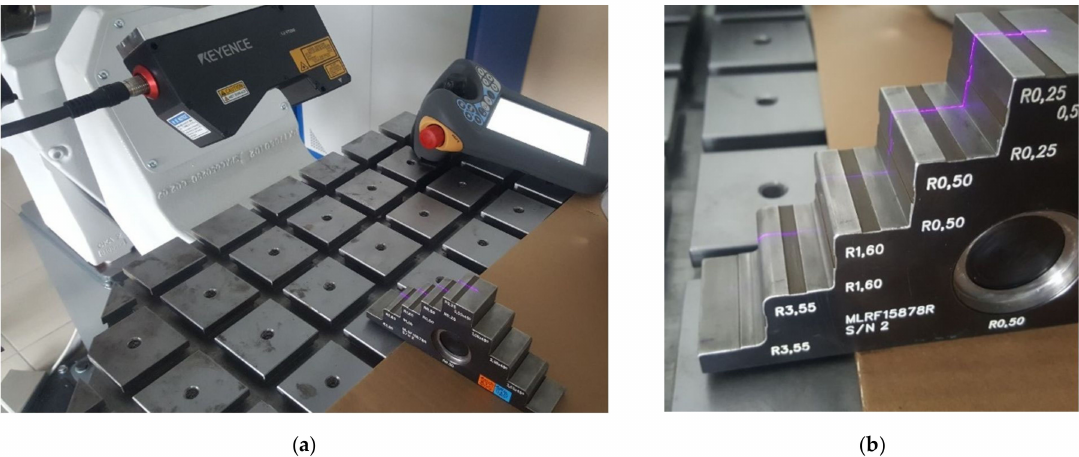
Figure 17. Measurement of the gauge elements: ( a ) overview; ( b ) detailed view of the gauge elements. During the tests, for known fillet radii the measurement area width was increased in increments of 0.1 mm (Figure 18).